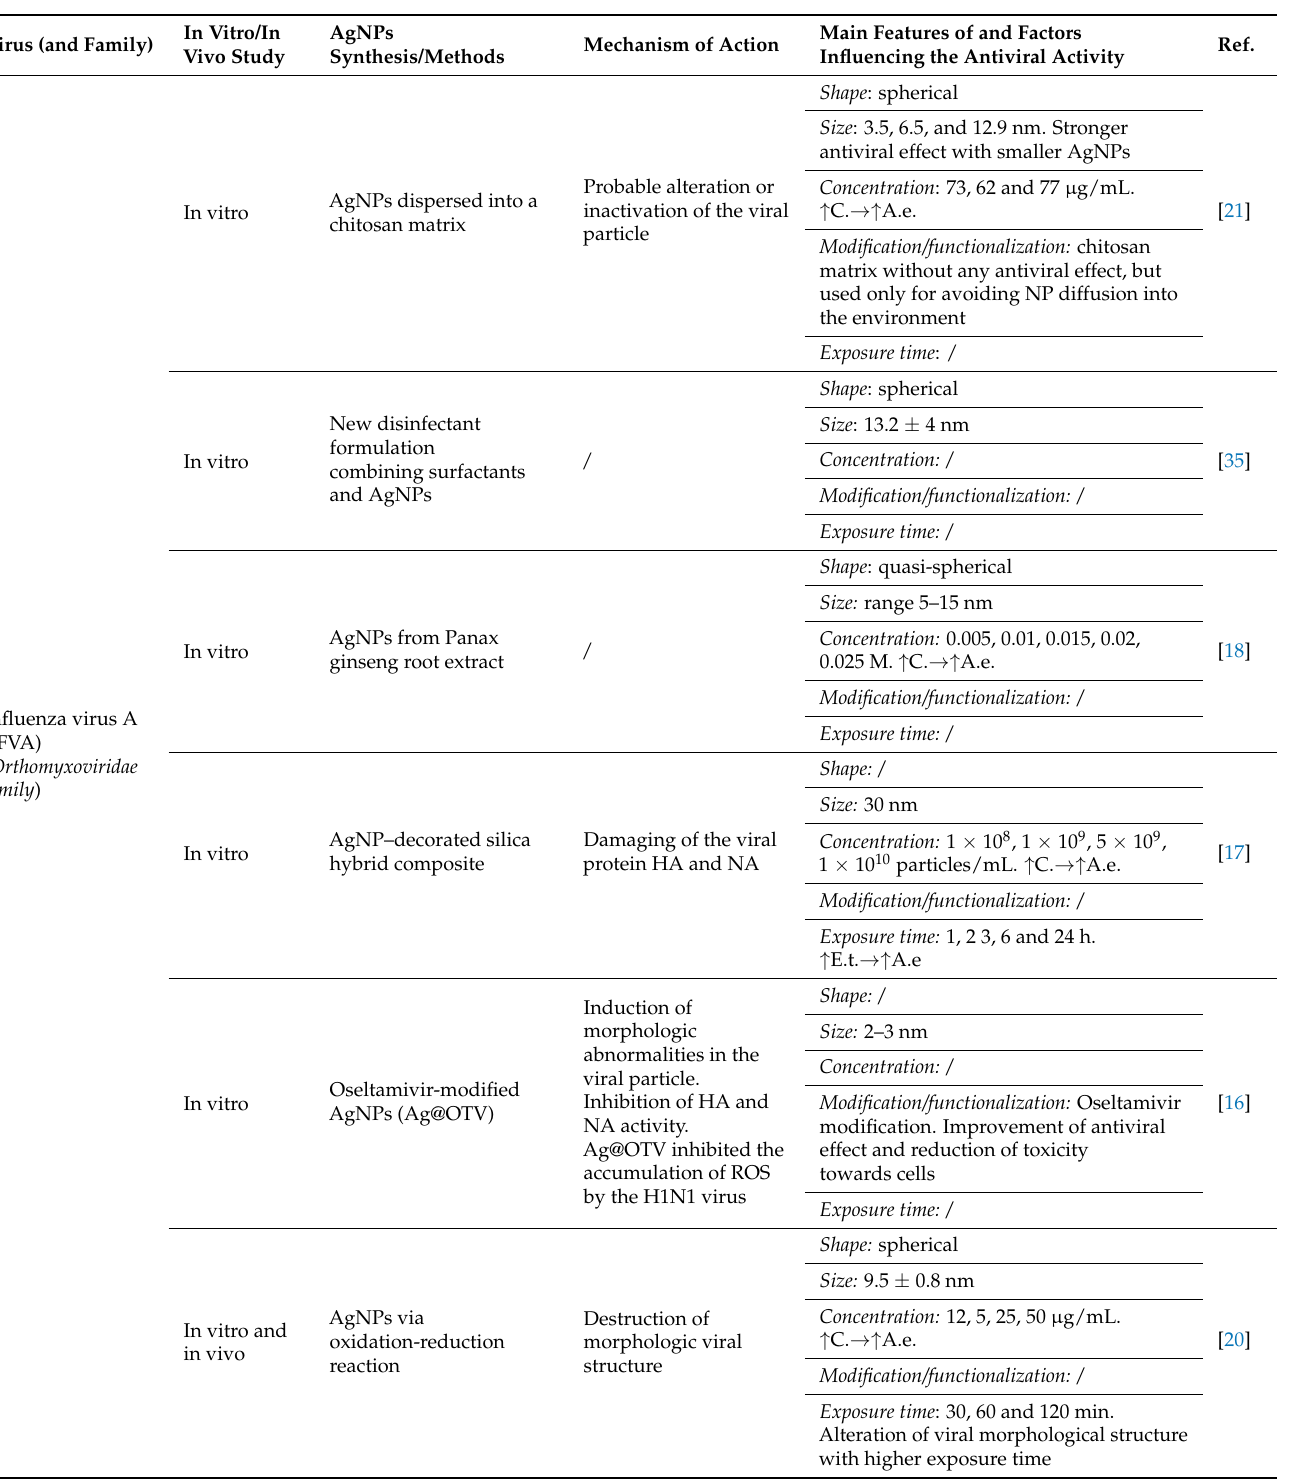
Table 1. Summary of the most relevant studies published since 2010 concerning the antiviral activity of